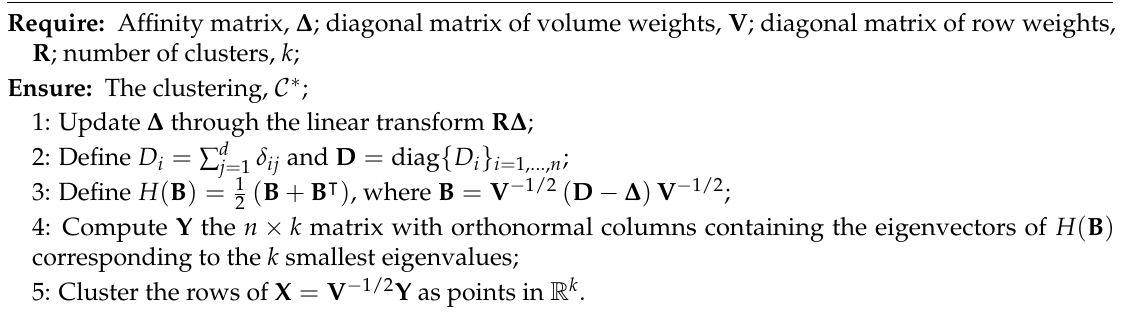
Algorithm A1 Best WCut (Meil˘a and Pentney 2007, Algorithm